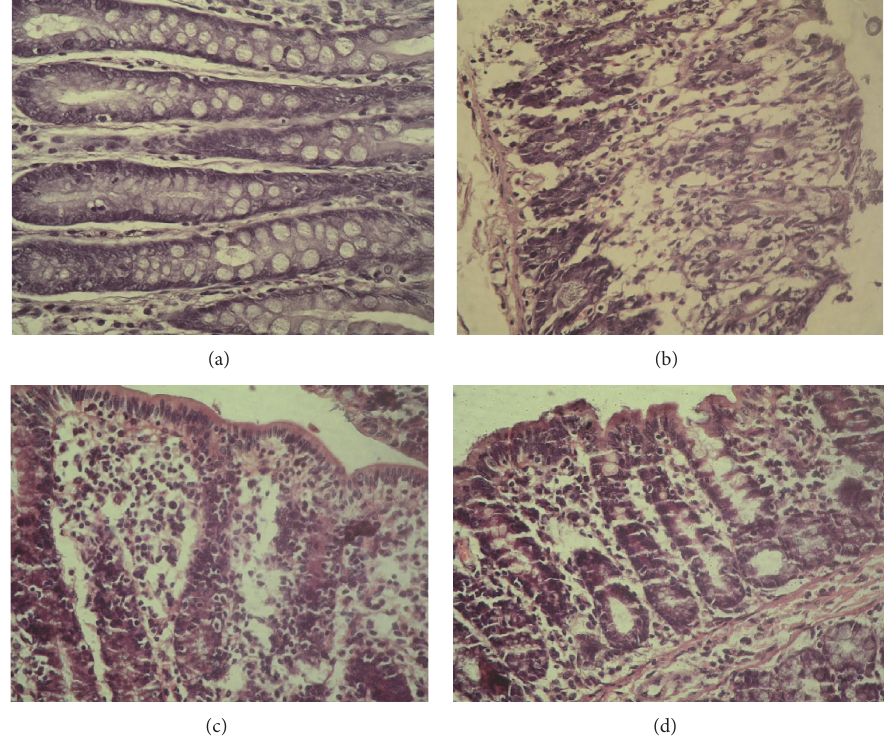
Figure 3: Microphotographs of upper colons for rats experiencing UC and treated with Prednisolone and MI-1. Hematoxylin-eosin orange staining, × 400. (a) Control group, (b) UC group, (c) UC + Prednisolone group, and (d) UC + MI-1